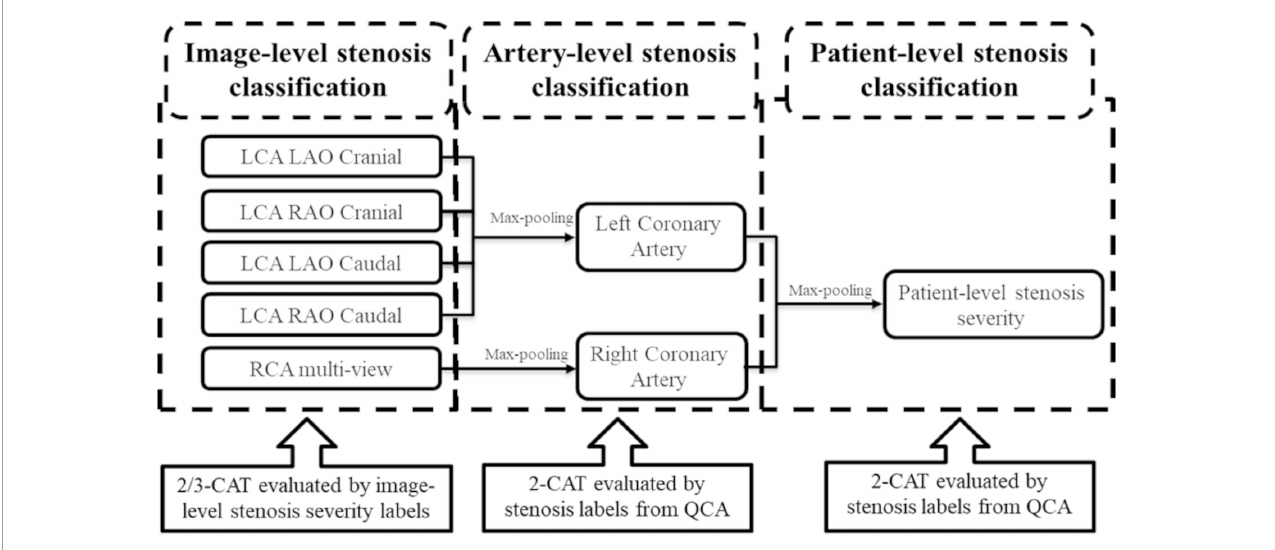
FIGURE2 The architecture of the output of the stenosis classification inception model. A max-pooling layer was added to the output of inception to evaluate the artery-level stenosis prediction and the patient-level stenosis prediction. LCA, left coronary artery; LAO, left anterior oblique; RAO, right anterior oblique; RCA, right coronary artery; QCA, quantitative coronary